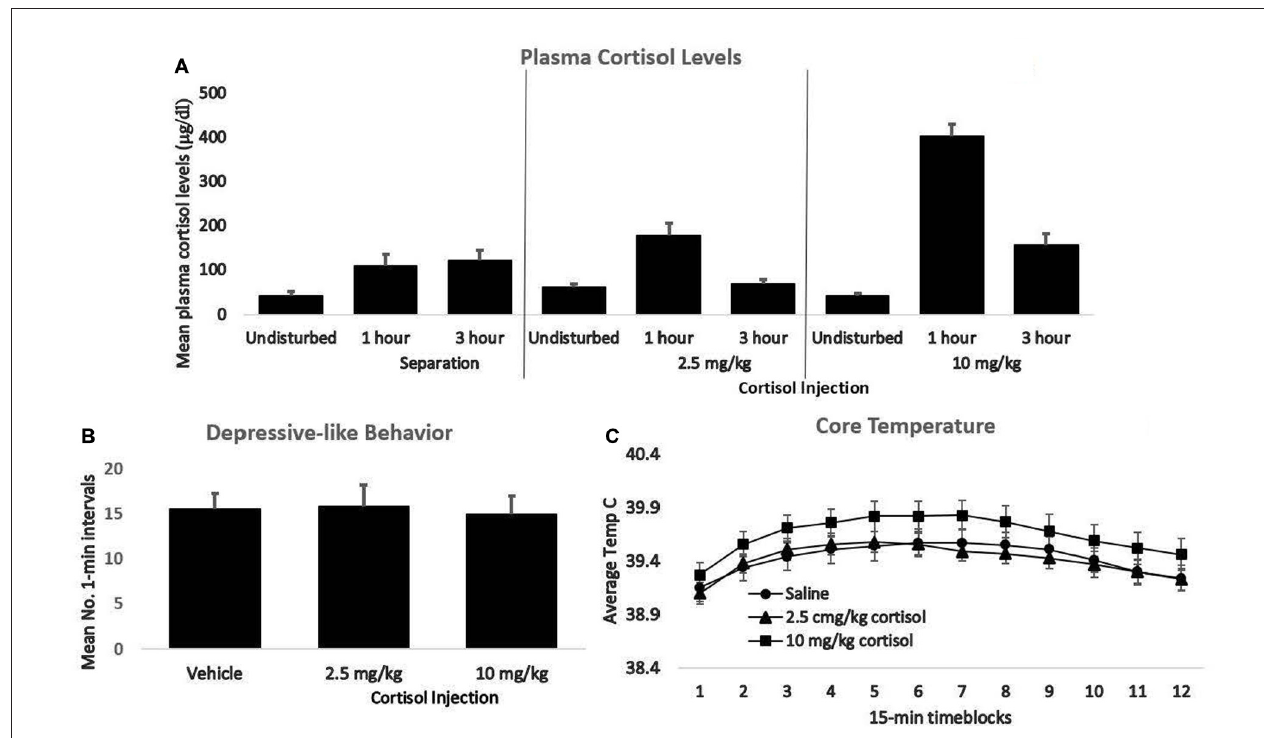
FIGURE 2 | (A) Mean plasma cortisol levels of young guinea pigs 1 and 3 h following either separation or injection of either 2.5 or 10 mg/kg of cortisol. For each group, cortisol values following no prior disturbance are presented for comparison. (B) The mean number of 1-min intervals pups that had been either undisturbed or injected with 2.5 or 10 mg/kg cortisol spent exhibiting the depressive-like crouched stance with eye-closure and extensive piloerection during separation the following day. (C) Mean core body temperature of the same three groups depicted in panel B during 15-min time blocks of the 3-h separation. In all panels, vertical lines represent standard errors of the means. There was no significant difference across groups for either behavior or core